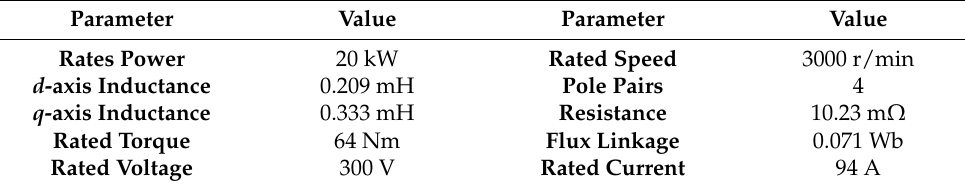
Figure 12. Photo of the experiment system. Table 2. IPMSM parameter.